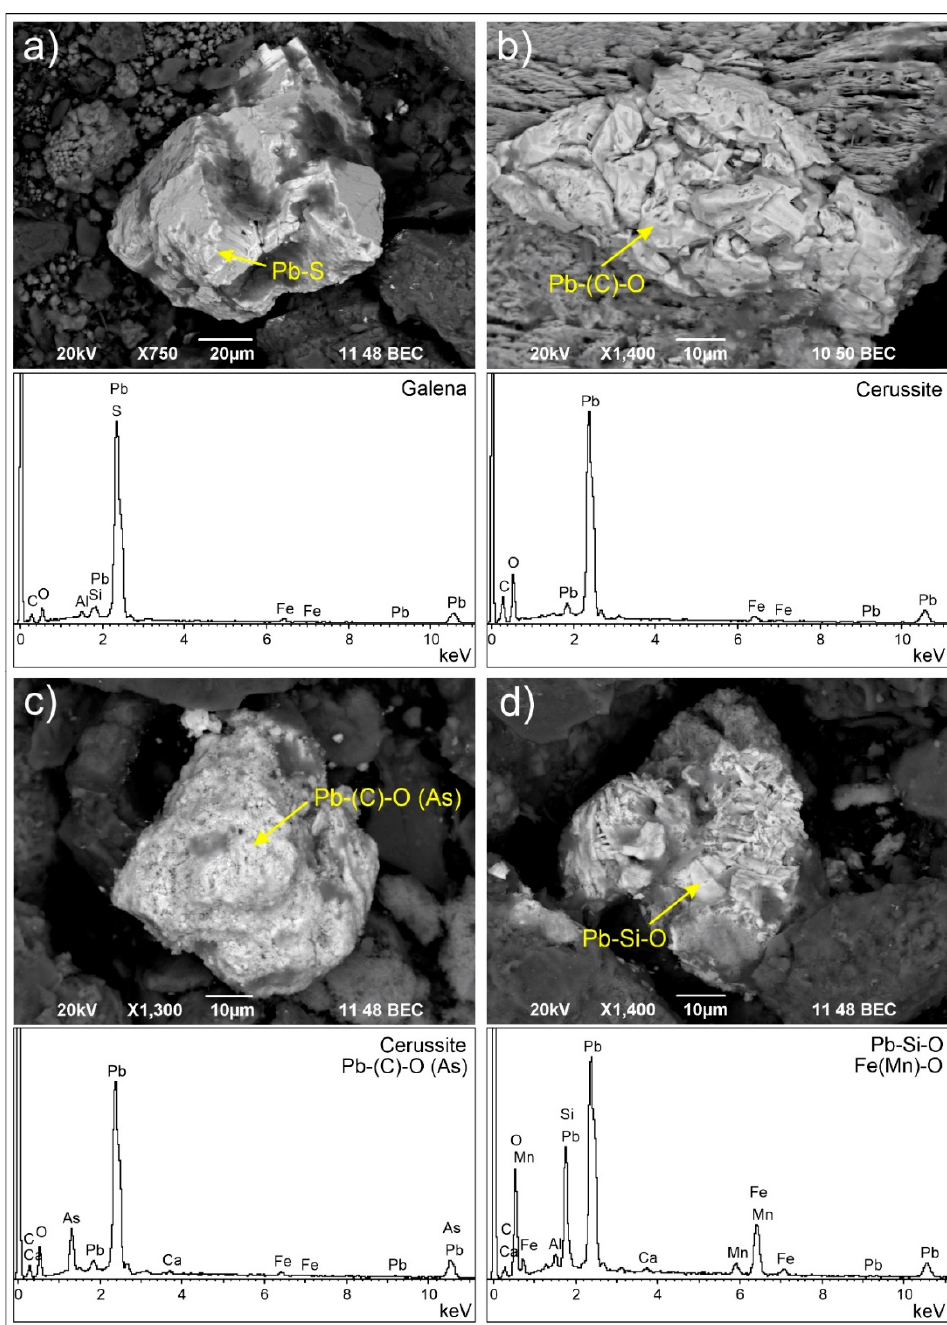
Figure 8. SEM(BSE) images and EDS spectra of solid Pb carriers in stream sediment and mine waste: ( a ) subhedral galena particle; ( b ) cerussite particle embedded in Fe(Mn)-oxide/oxyhydroxide with high Pb content; ( c ) porous Pb-(C)-O with As, probably cerussite; ( d ) cluster of Pb-Si-O crystals and Fe(Mn)-oxide/oxyhydroxide